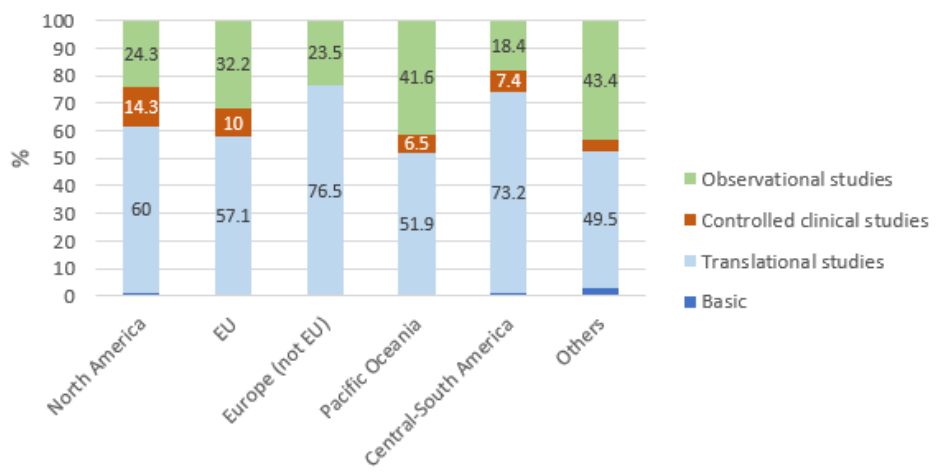
Figure 7. Distribution of the types of articles regarding the geographical area. There were three outstanding topics: preventive treatments (27.6%), diet (23.4%) and hard tissues (22.9%). Table 2 shows the distribution of the topics according to the geographic areas. A dominant trend in studies about prevention and diet in Central-South America was found, while in North America, the high percentage of studies about pathogenesis and clinical manifestations is Table 2. Distribution of the topics regarding the geographic areas.